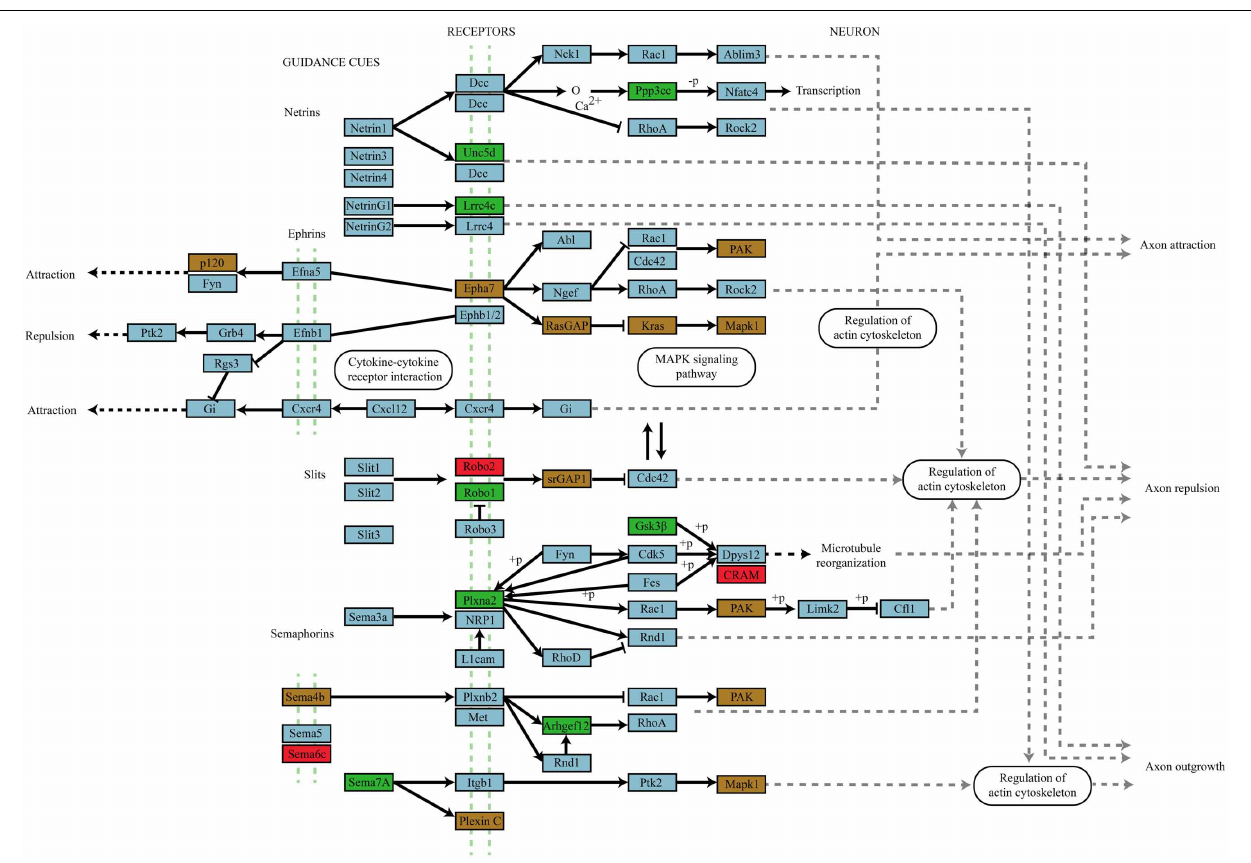
FIGURE 6 | Axon navigation pathway targeting by miRNAs that differentially associate with Ago2 in an activity-dependent manner. Genes targeted by miRNAs that differentially associate with Ago2 in an activity-dependent manner are color coded by whether they are targeted by enhanced (green box), depleted (red box), or by both enhanced and